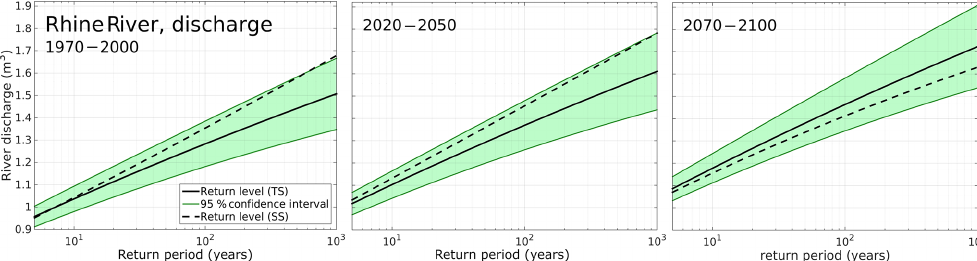
Figure 8. Return level plots for the discharge of the Rhine River at its mouth, TS (black continuous line), 95% confidence interval for the TS methodology (green band), and SS methodology (black dashed line) for the time slices 1970–2000, 2020–2050, and 2070–2100.